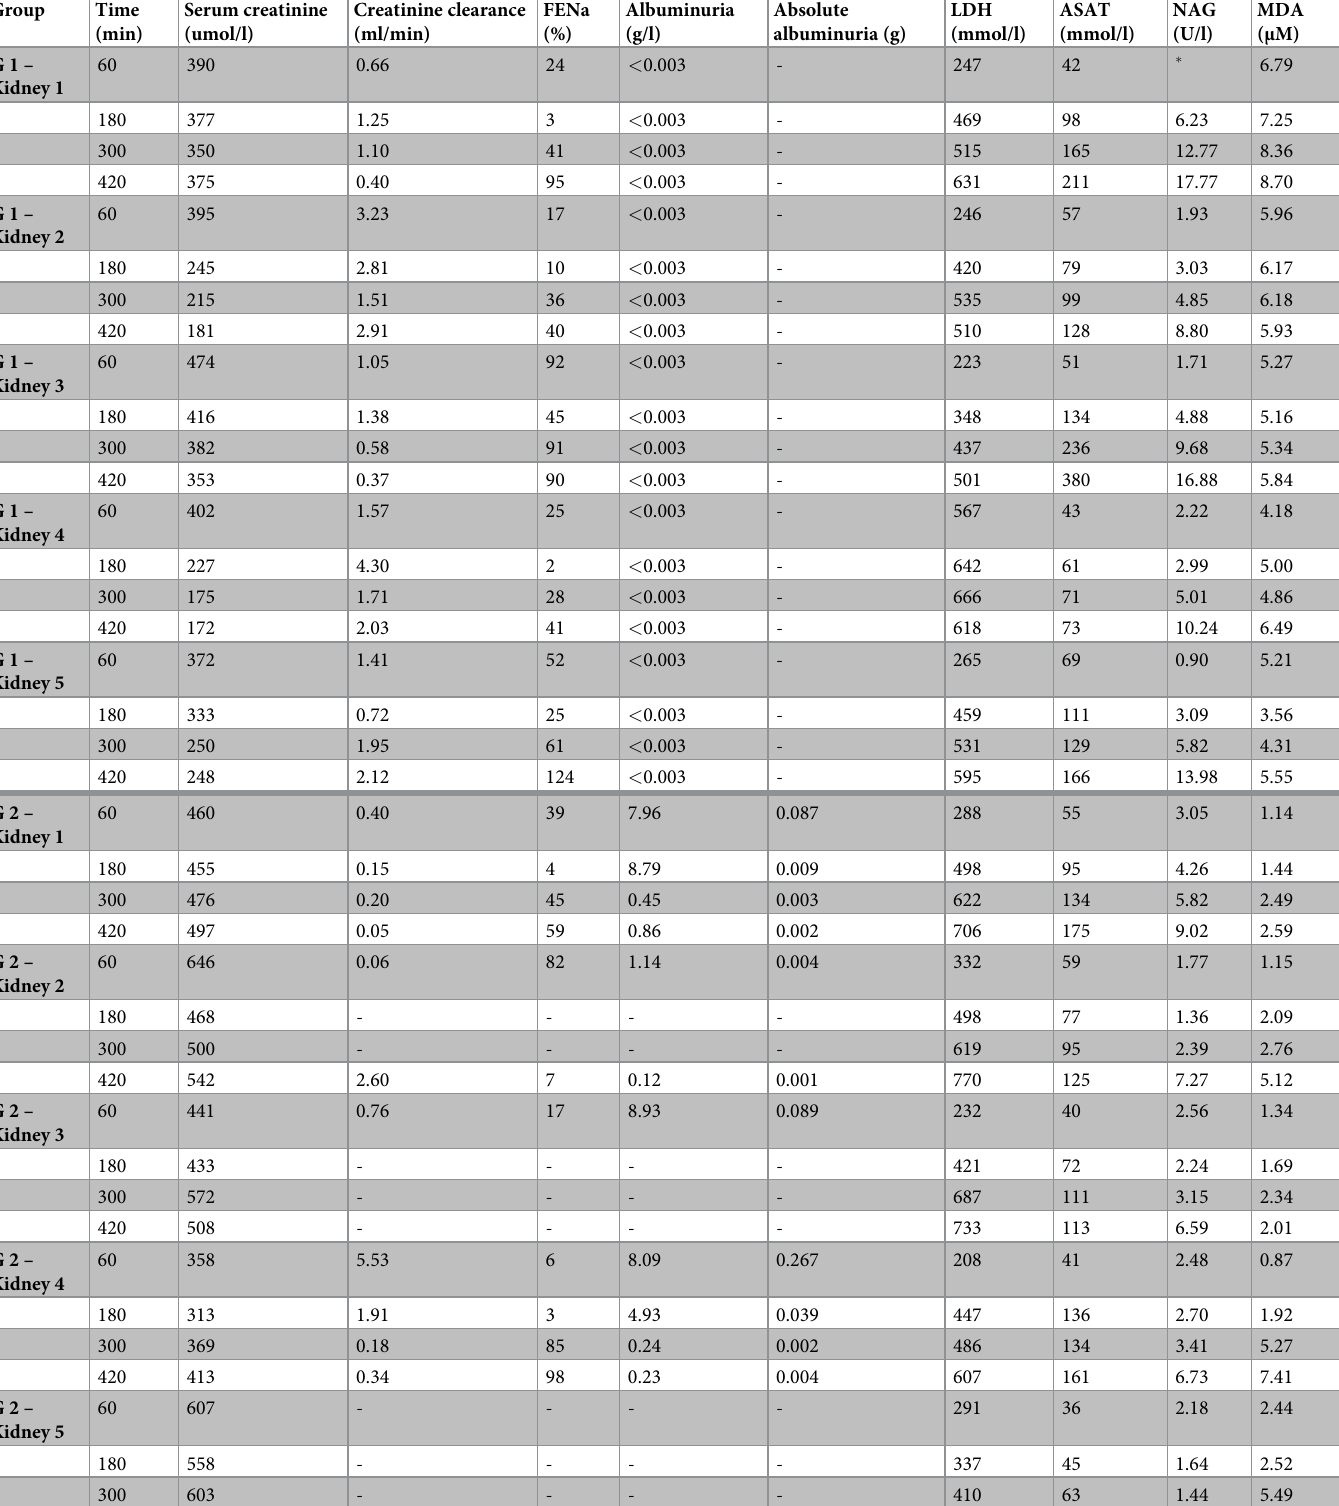
Table 3. Functional and injury parameters throughout